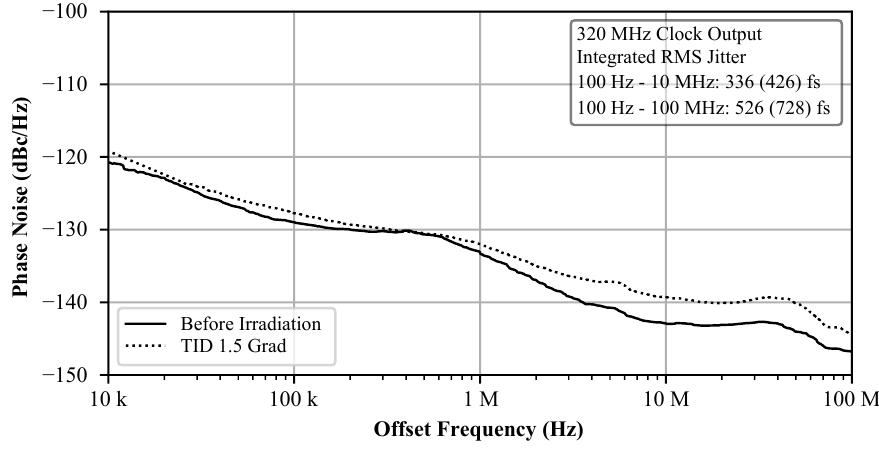
Figure 8. Closed-loop phase noise measurement of an All-Digital PLL circuit. Pre- and post- irradiation measurements are shown in solid and dashed lines, respectively. Values in parentheses indicate post-irradiation